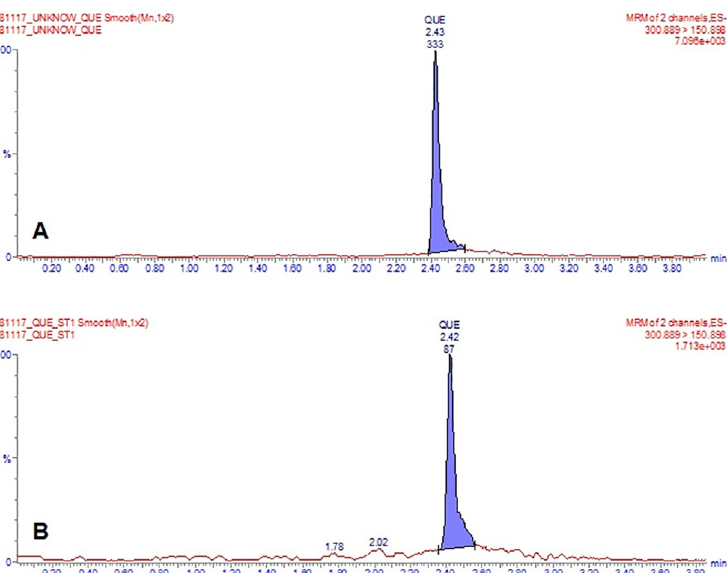
Fig 4. UPLC chromatogram of methanolic extract of Flavobacterium sp. (a) and quercetin as the standard